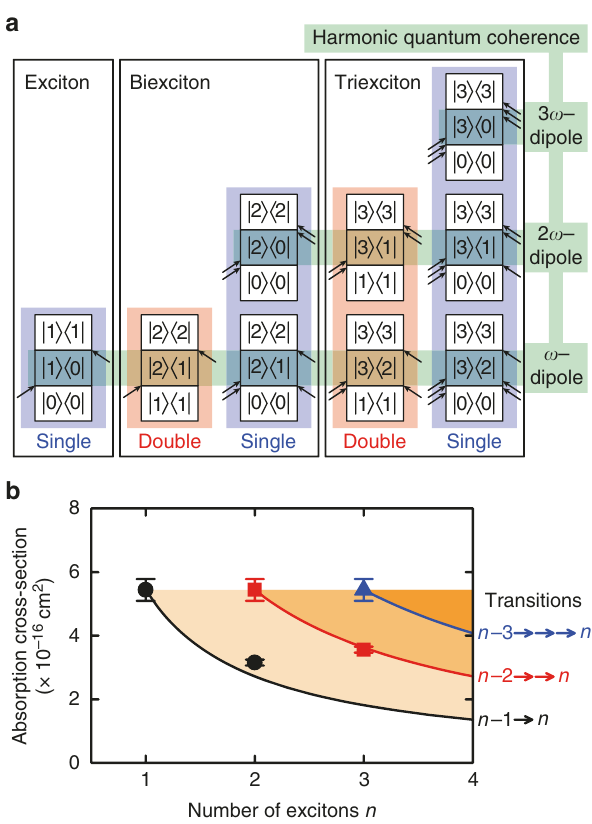
Fig. 5 Excitation sequences and correlation of the absorption cross-section with exciton number. a Double-sided Feynman diagrams of single exciton, biexciton, and triexciton generation processes. b Correlation between absorption cross-section and number of excitons. The theoretically predicted absorption cross-sections are shown with the solid curves, which depend on the transitions indicated on the right side of the fi gure. Error bars represent the uncertainty in the determination of the absorption cross-